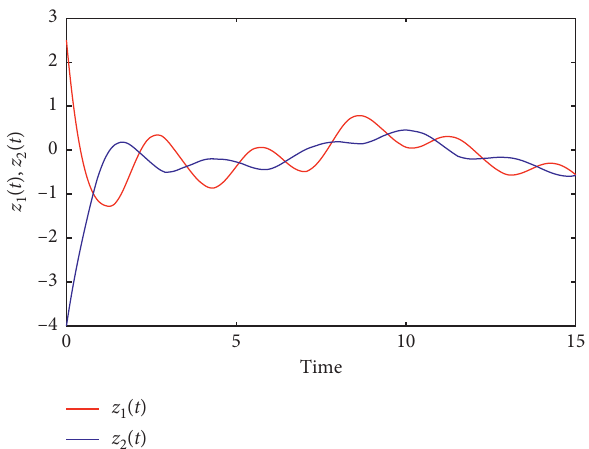
Figure 2: State trajectories of synchronization error system without control.